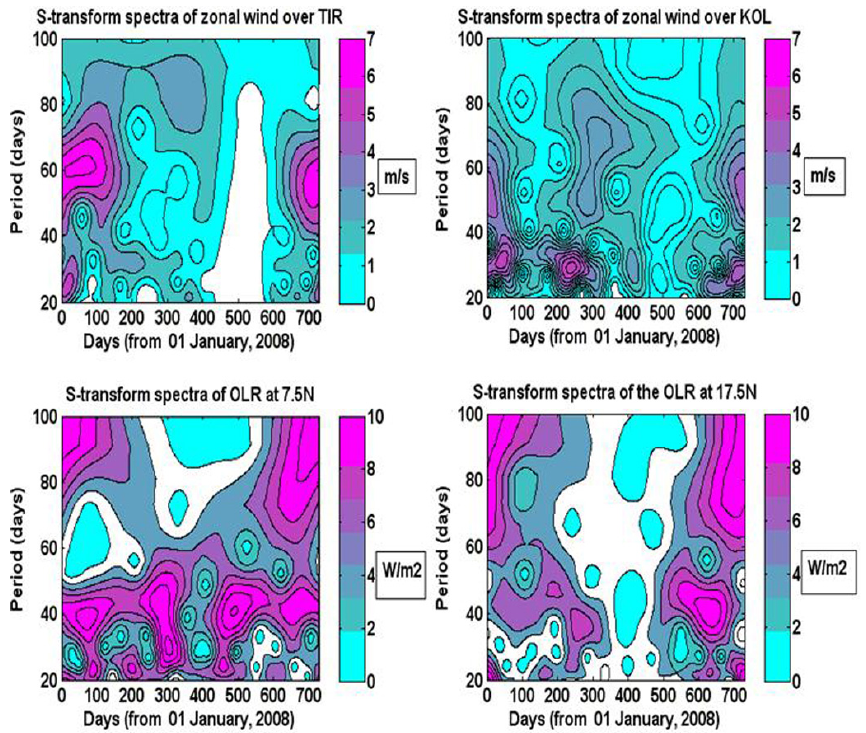
Fig. 10. Comparison of the ISO in zonal wind with ISO in convective activity.